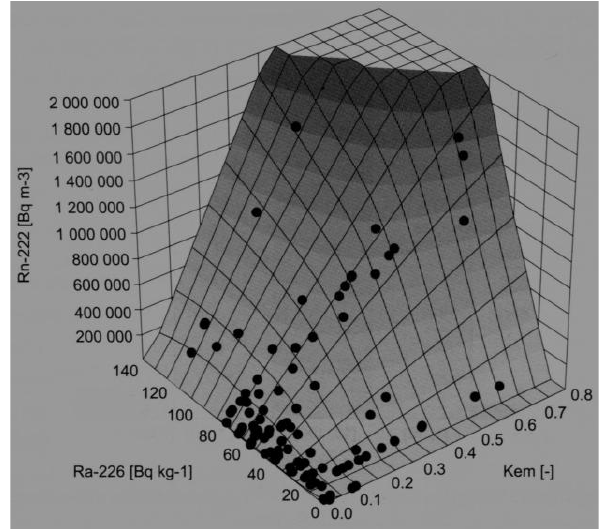
Fig. 2. Correlation between mean 222 Rn activity concentration in the groundwater and mean content of 226 Ra in its reservoir rock ( q ) and the value of the emanation coefficient ( K em ) of this rock for 111 selected groundwater intakes in the area of the Sudetes (SW Poland) (according to Przylibski,